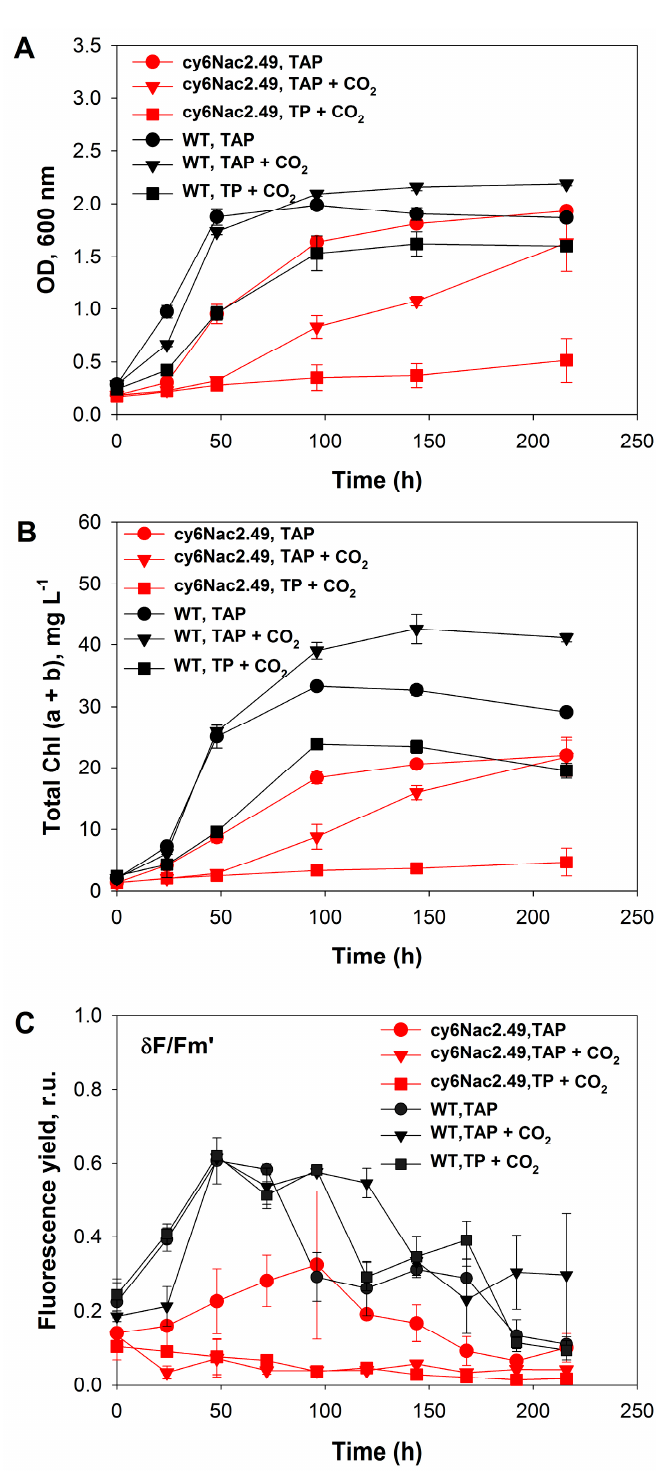
Figure 1. Growth and maximum photosynthetic yield during continuous illumination (10 W·m − 2 ) of C. reinhardtii strain cy6Nac2.49 (red) and it is parental wild-type (black) under photoheterotrophic (TAP), photomixotrophic (TAP + CO 2 ) and autotrophic (TP + CO 2 ) conditions. ( A ) optical density (OD), ( B ) the total (a + b) chlorophyll (Chl) concentration and ( C ) the δ Fv/Fm’. TAP tris-acetate-phosphate medium; TP: tris-phosphate medium; δ Fv/Fm’: the maximum fluorescence value recorded during illumination; r.u.: relative units.